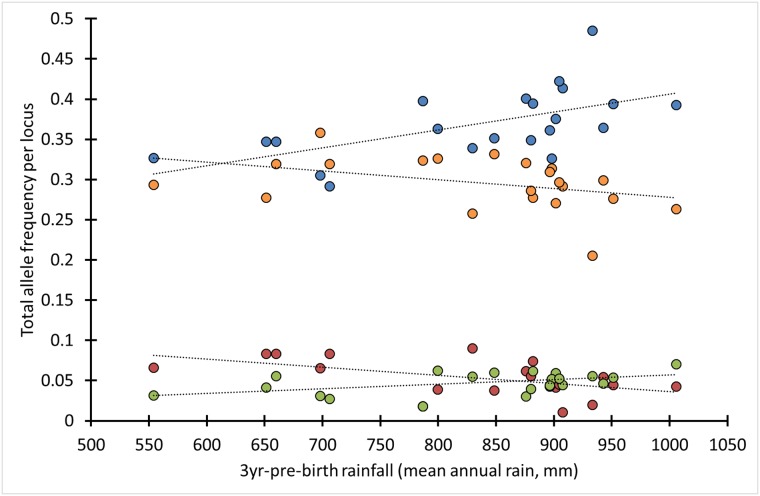
Correlations between birth-year cohort frequencies of SAEindv alleles and 3yr-pre-birth rainfall.Blue data points: SAEindvN,A<1 alleles (nine alleles at eight loci): ρ = 0.62, P = 0.0051; red data points: SAEindvN,A>1 alleles (five alleles at five loci): ρ = -0.52, P = 0.017; green data points: SAEindvO,A>1 alleles (four alleles at four loci): ρ = 0.42, P = 0.083; orange data points: SAEindvO,A<1 alleles (16 alleles at nine loci): ρ = -0.49, P = 0.031; average |ρ| = 0.51, P = 0.00018; Nbirth-year-cohorts = 21, ≥ 4 individuals per birth-year cohort genotyped, Nindividuals = 380. SAEindvO alleles based on Asex-anta, SAEindvN alleles based on Amale-spec. Test 4, Table 2.